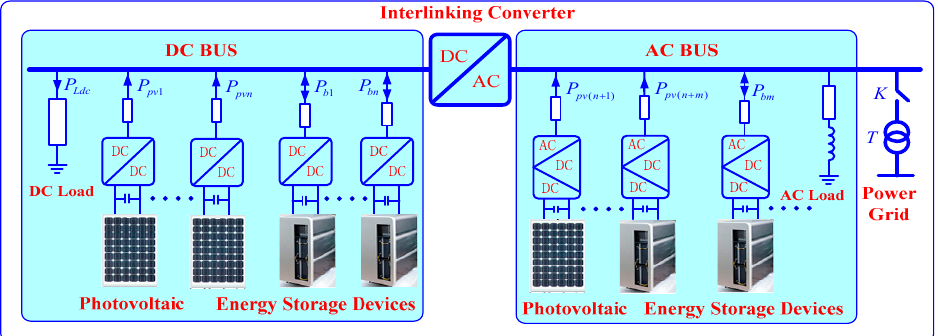
Figure 1. Hybrid microgrid configuration with energy storage (ES) and photovoltaic (PV) units.